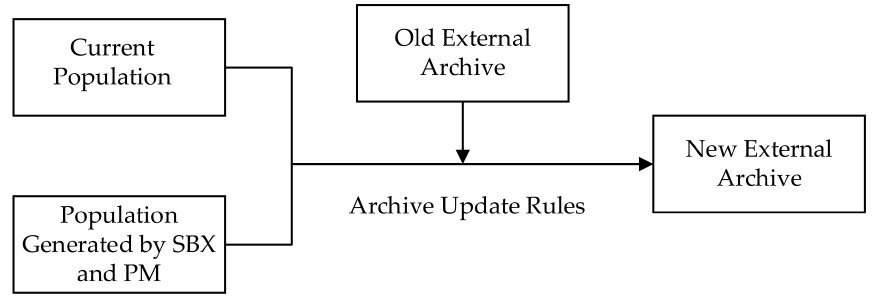
Figure 2. The process of generating new external